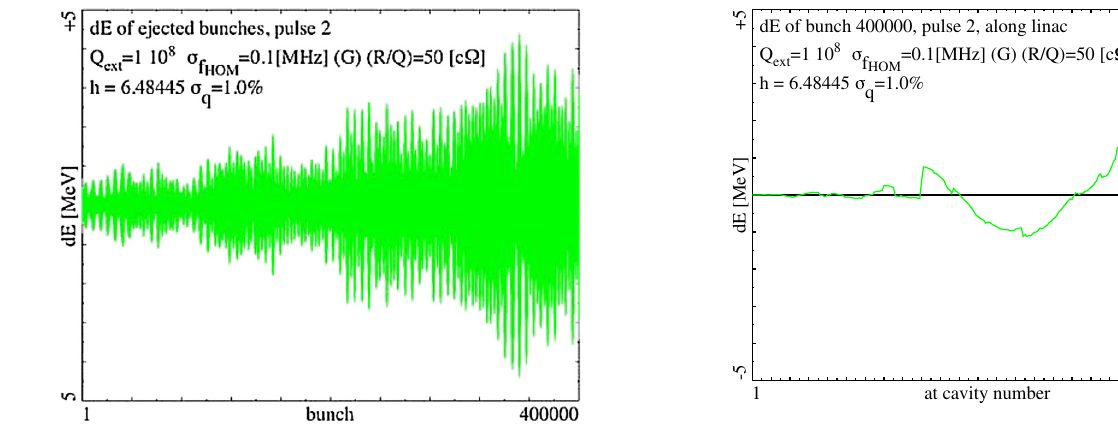
FIG. 63. (Color) dE [ (cid:3) 5 MeV ] for the last bunch of pulse 2 along the linac. The corresponding plots (not shown) to con- ditions of Fig. 6 (no noise) and Fig. 7 (phase noise) show considerably smaller dE excursions. dt of bunch 400000, pulse 2, along linac